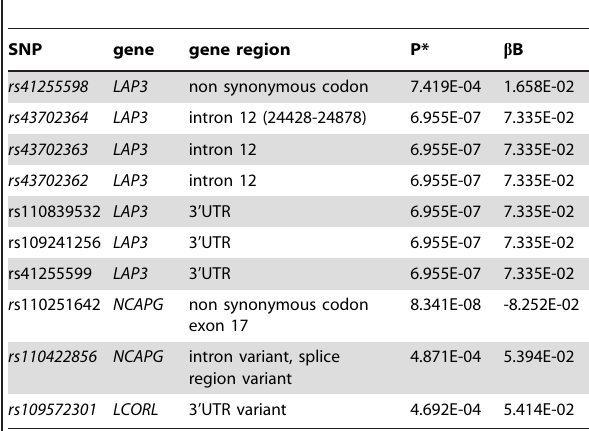
Table 2. SNP name, gene name, region within the gene, significance level (P*) and minor allele effect ( b B) for the SNPs selected in the LAP3 , NCAPG and LCORL genes and significantly associated to direct calving